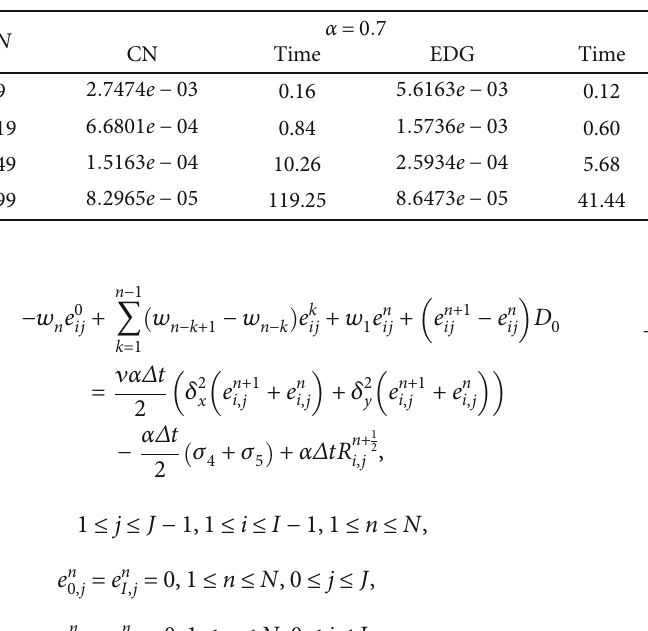
Table 2: Absolute errors of Example 13 at T = 1 for Re = 10 , Δ t = 0 : 01 , α = 0 : 7 , and α = 0 : 9